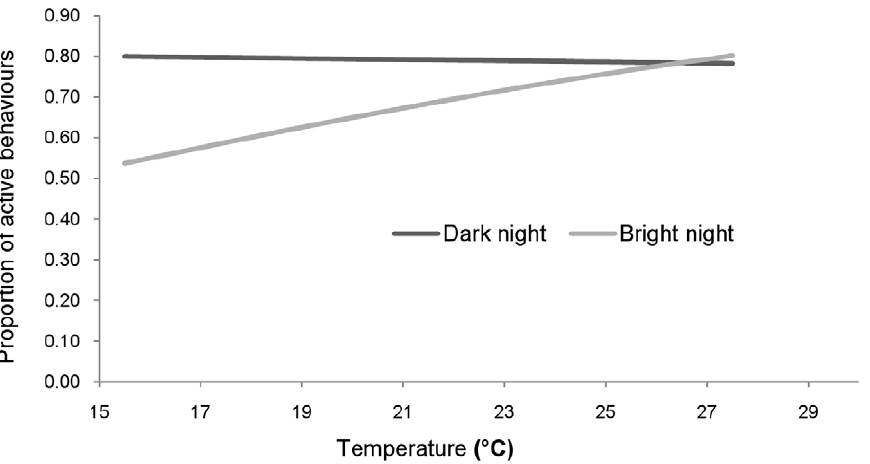
Figure 3. Interaction between moonlight and temperature on activity of the pygmy loris as predicted by the model.